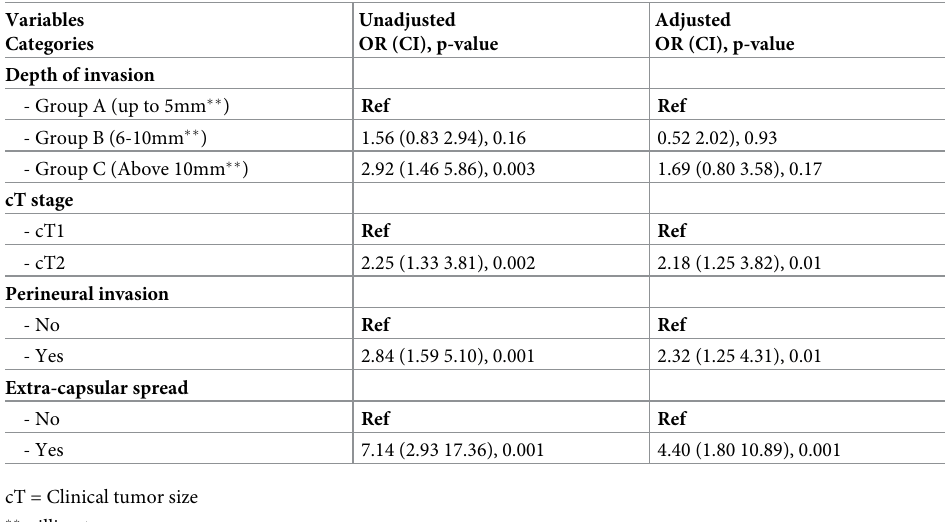
Table 5. Independent risk factors of nodal